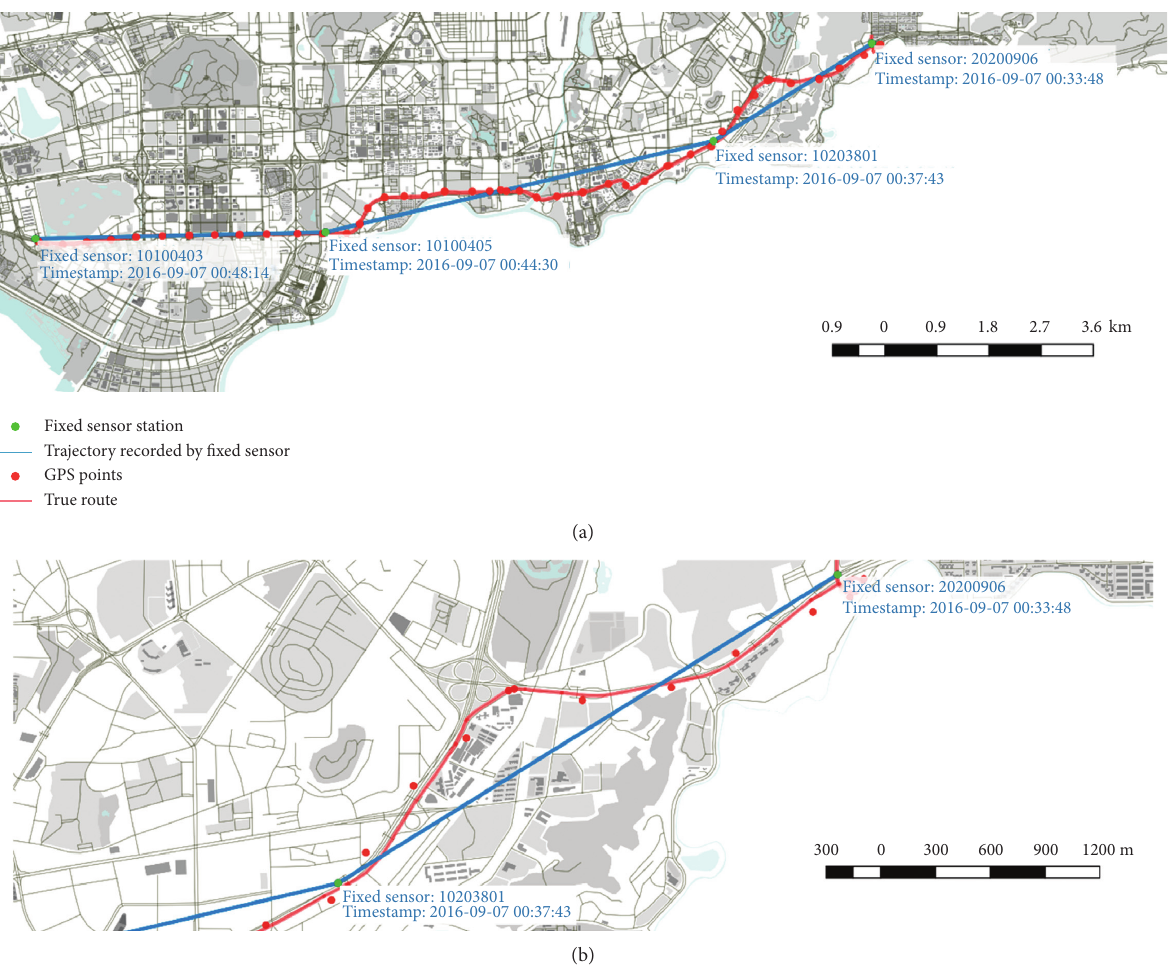
Figure 1: Comparison of fixed sensor and probe sensor data. (a) Macroscopic and (b) microscopic views of one vehicle’s trajectories recorded by the probe and fixed